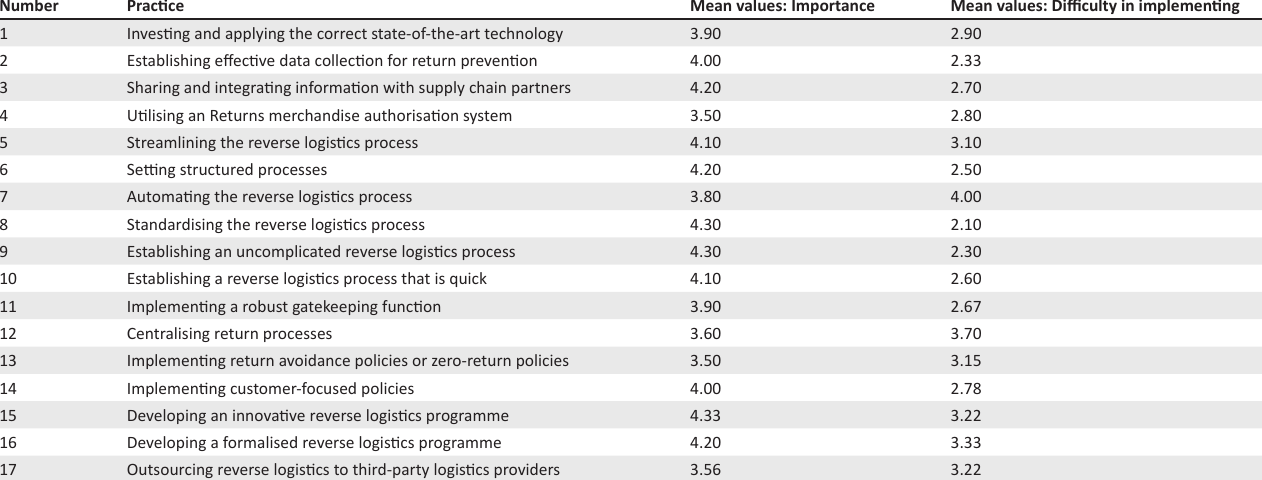
TABLE 1: Mean values of the importance and difficulty in implementing practices. Number